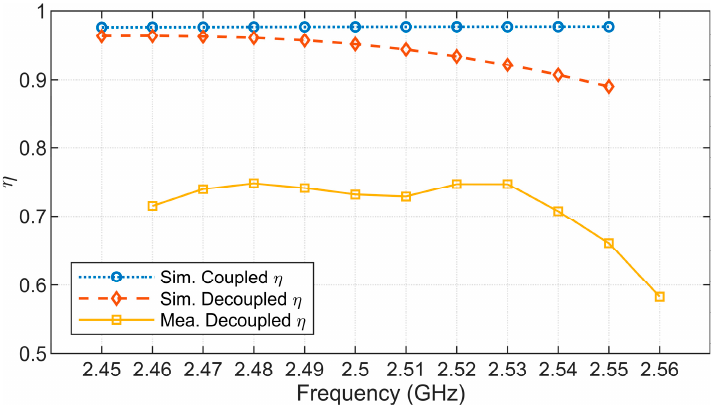
Figure 14. Antenna e ffi ciency.